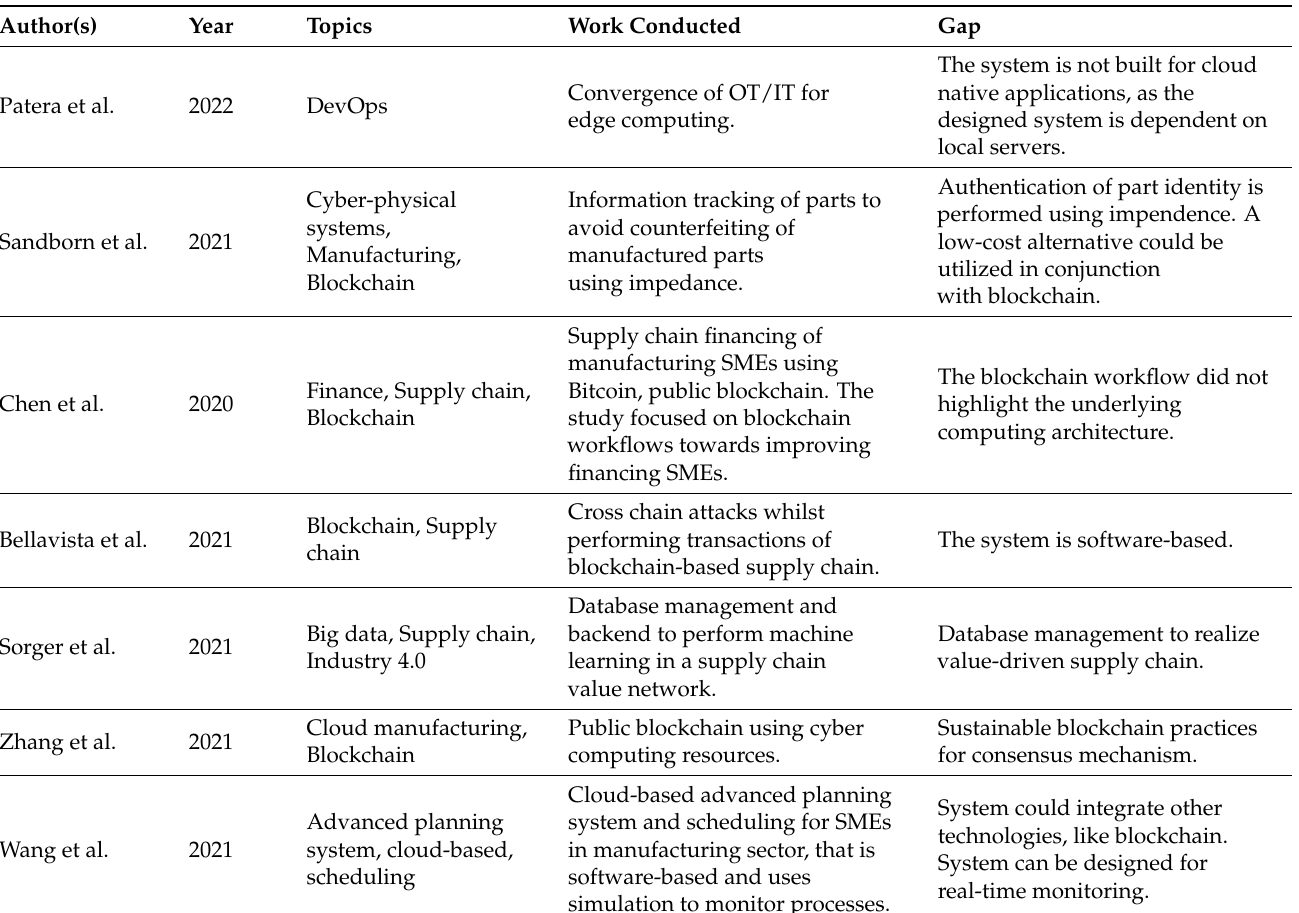
Table 1. Summary of related work and gaps identified in